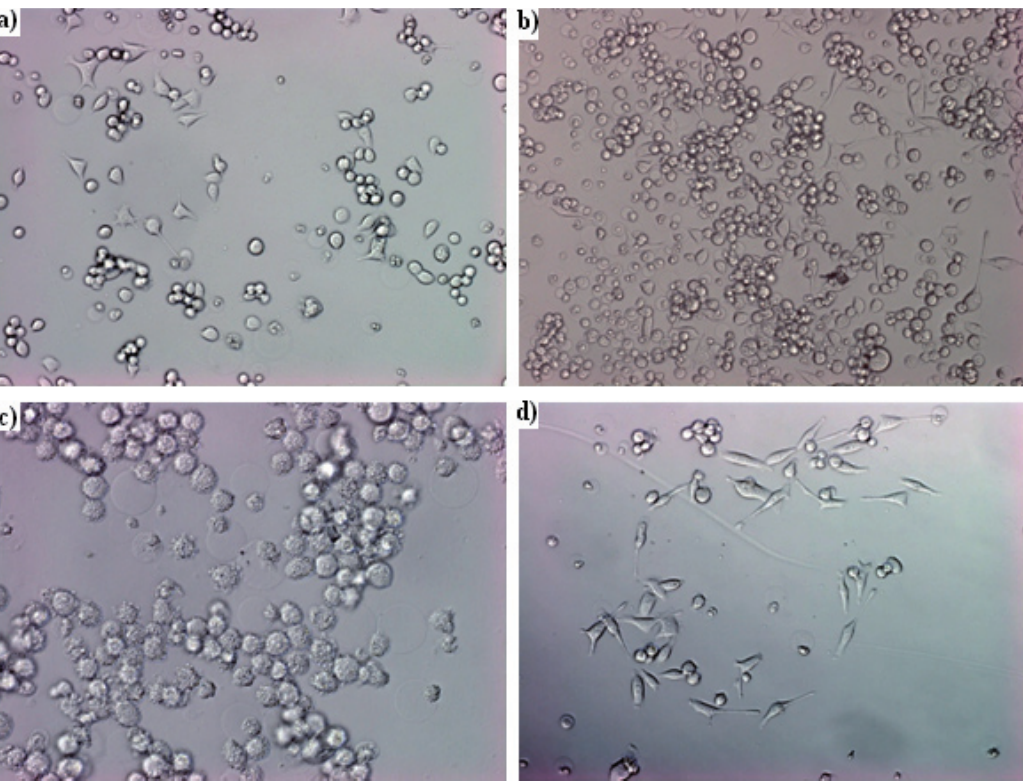
Fig. 1: Phenotype changes of HeLa cells in a) 0.1 μg/ml RE – ethanolic extract of wild growing plants, b) 10 μg/ml RDE – ethanolic extract of cultured plants, c) 1000 μg/ml RE – ethanolic extract of wild growing plants, and d) untreated cells